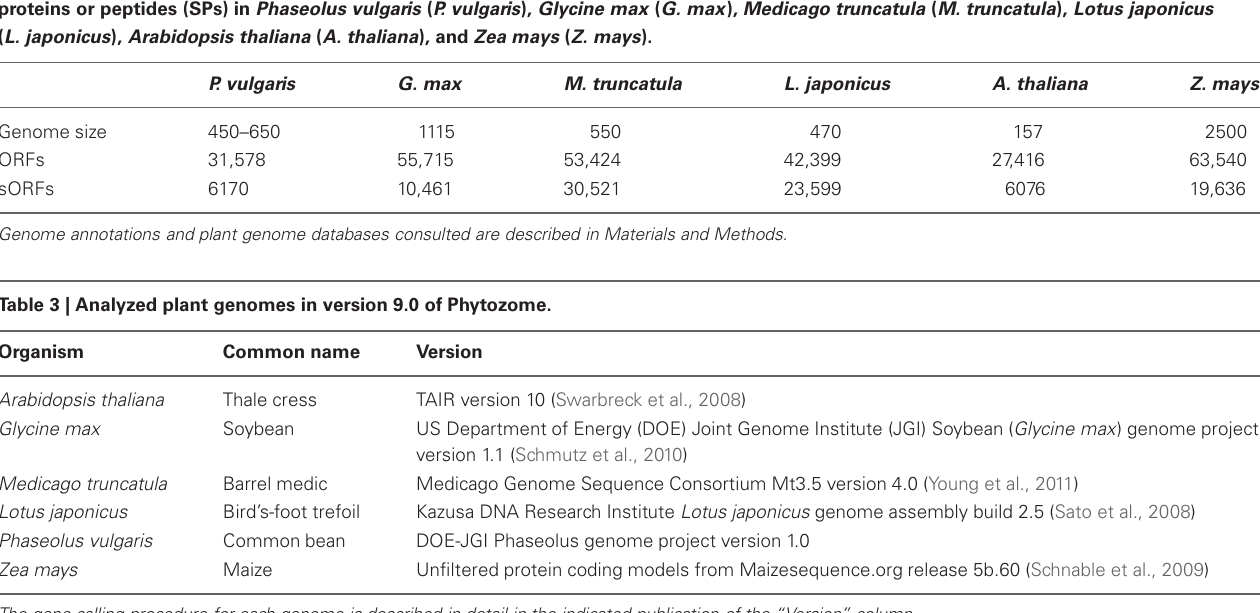
The gene-calling procedure for each genome is described in detail in the indicated publication of the “Version”